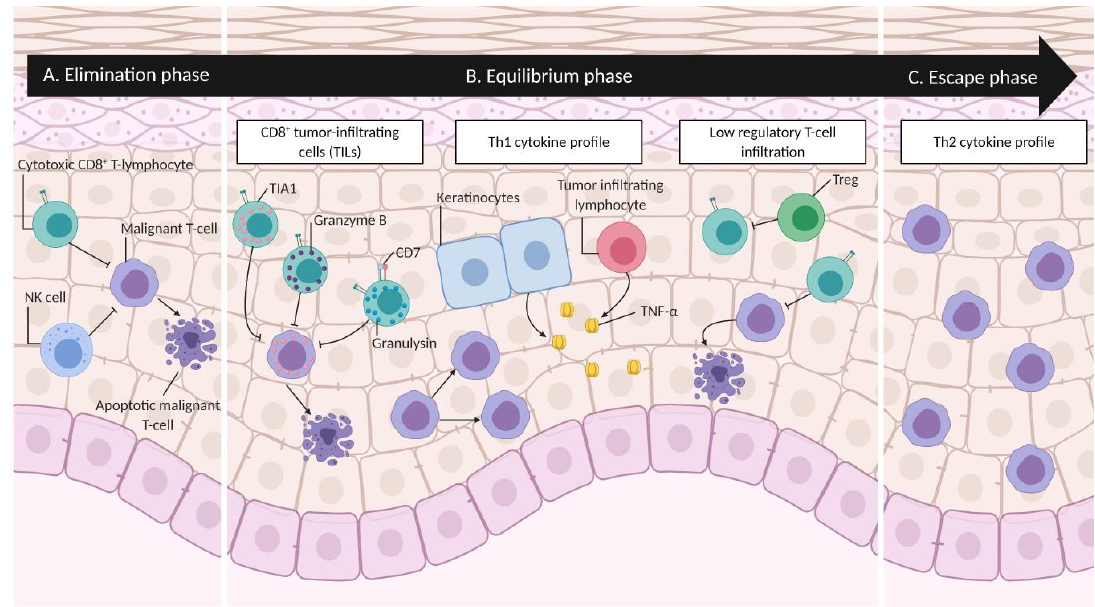
Figure 2. Cancer immunoediting in mycosis fungoides. Each phase of cancer immunoediting can be associated with specific cellular and cytokine profiles. In the elimination phase ( A ), the immune system, depicted here by cytotoxic CD8+ T-lymphocytes and Natural Killer (NK) cells, controls the proliferation of malignant T-cells, keeping them occult/incognito. Several evidences suggest that HMF remains in the equilibrium phase ( B ). Specifically, CD8+ tumor-infiltrating cells (TILs) secrete TIA1, granzyme B, and granulysin, which are cytotoxic granules that induce apoptosis in malignant T-cells. The production of Tumor Necrosis Factor- α TNF- α by keratinocytes and TILs induce an active antitumor immune response. A low level of regulatory T-cell (Treg) infiltration reported in HMF suggests that TILs are able to induce apoptosis in malignant T-cells. Finally, in the escape phase ( C ), a shift to Th2 cytokine profile allows malignant cells to overcome immune recognition and proliferate in the skin and beyond. Figure created with BioRender.com.